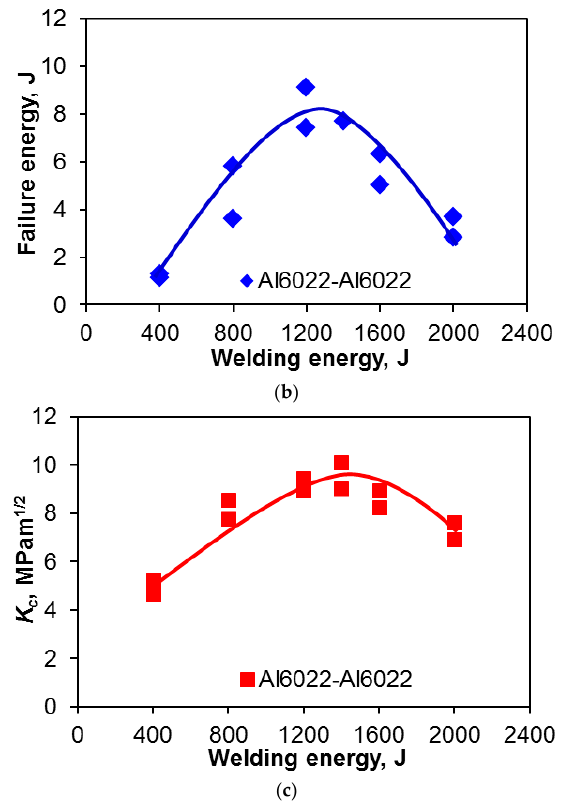
Figure 4. ( a ) The tensile lap shear strength; ( b ) total failure energy; and ( c ) critical stress intensity factor ( K c ) of USWed 6022-T43 Al alloy as a function of welding energy at a welding power of 2 kW and a clamping pressure of 0.4 MPa.